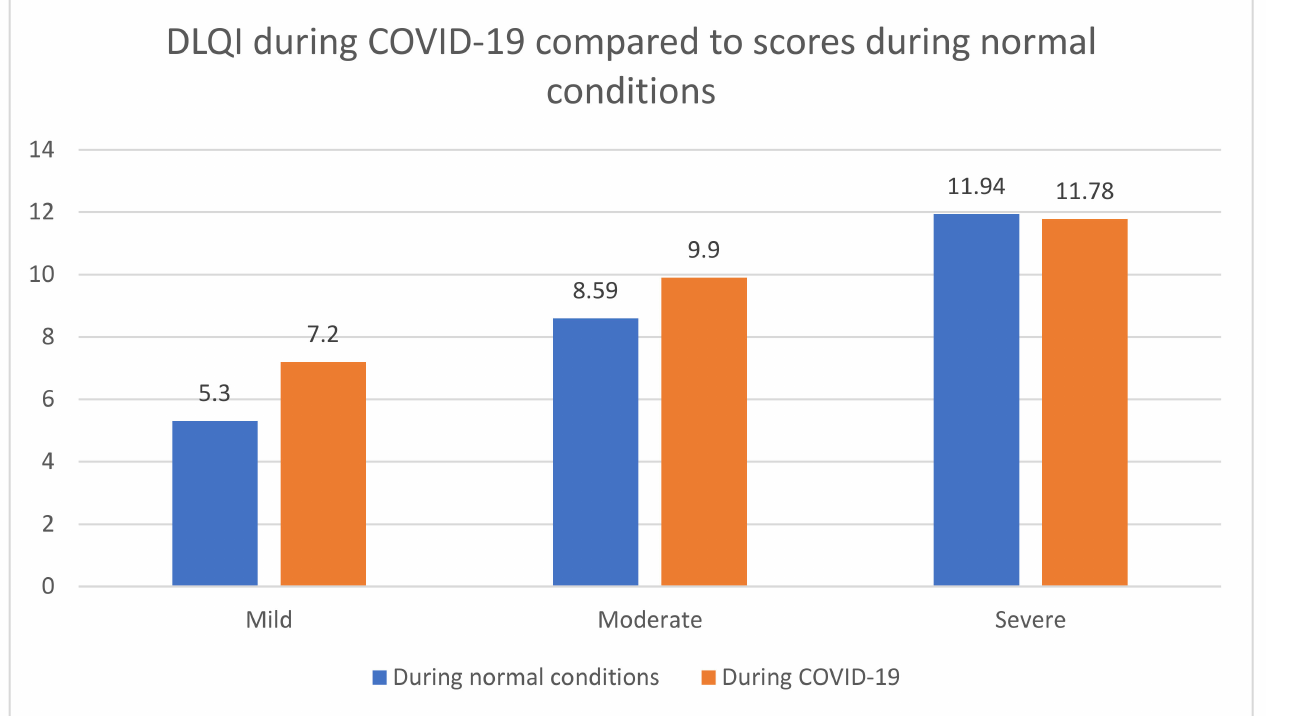
Figure 2. DLQI during COVID-19 compared to the scores during normal conditions. Adults with AD during non-epidemic conditions, compared with those with AD during the coronavirus pandemic, had lower average Hospital Anxiety and Depression Scale for anxiety (HADS-A) (8.6 ± 2.1 vs. 7.7 ± 1.8, p < 0.05) and depression (HADS-D) (7.9 ± 1.9 vs. 6.0 ± 1.5, p < 0.05) scores. Tables 1 and 2 present the HADS-A and HADS-D scores during normal conditions and during the COVID-19 pandemic [14]. Most of the patients reported exacerbation of skin lesions. The study established that working patients had more severe depression compared with patients who did not